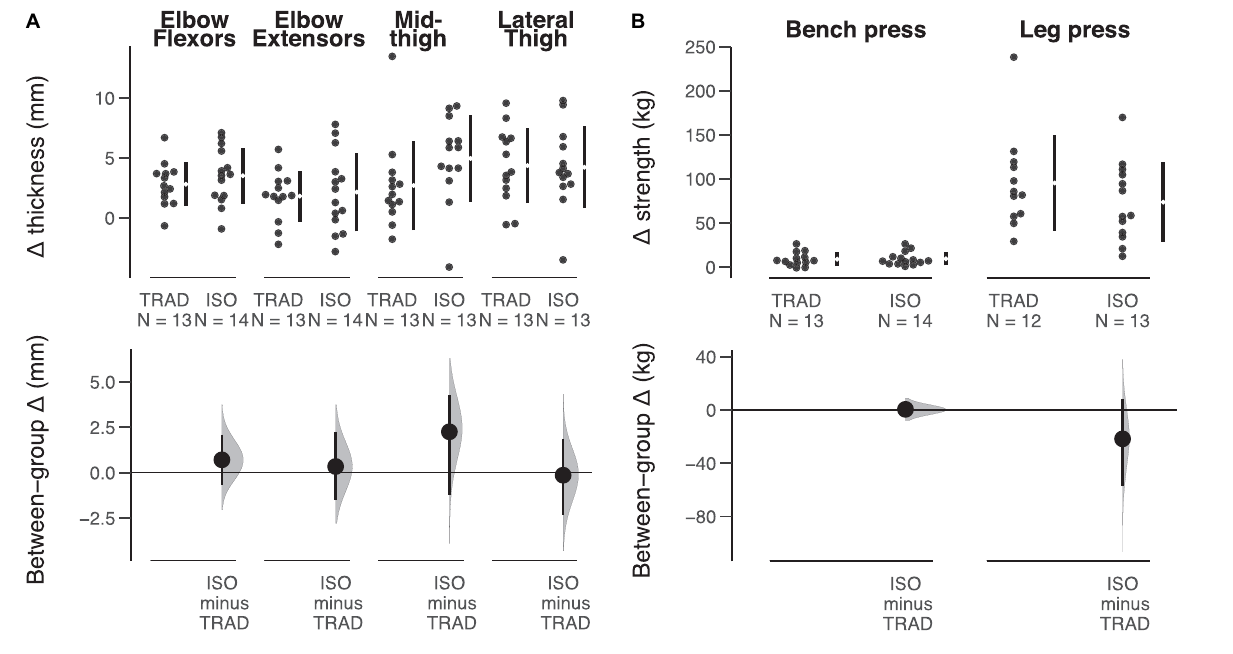
FIGURE 2 | Muscle thickness and strength outcomes. Top plots represent adjusted individual changes, and bottom plots represent adjusted between-group effects. (A) Muscle thickness outcomes of the biceps brachii, triceps brachii, rectus femoris, and vastus lateralis. (B) Strength outcomes for both bench press and leg press 1RM. Error bars indicate 90% CIs, and distributions represent the bias-corrected and accelerated bootstrap distribution of the adjusted group